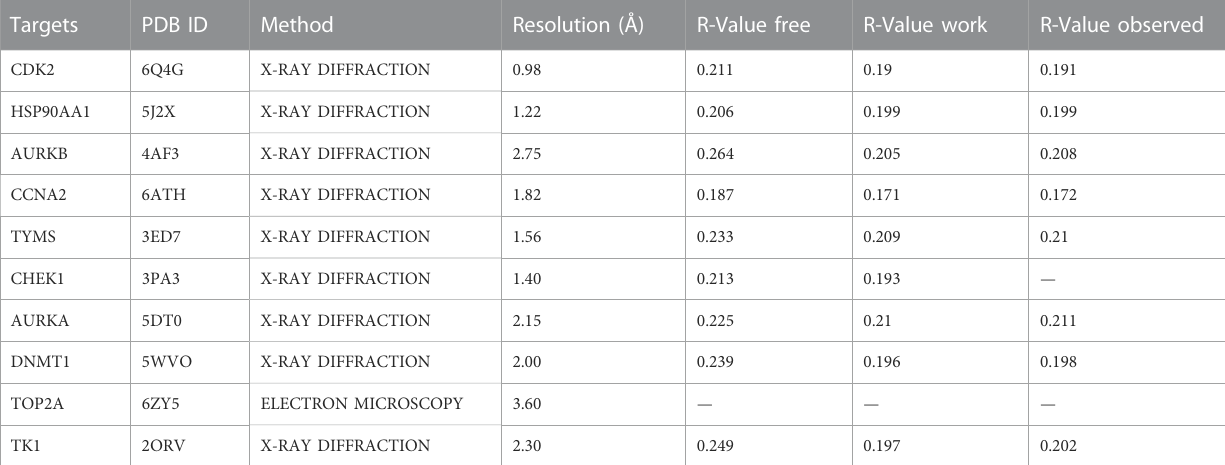
TABLE 2 Details of the protein targets in the PDB database.